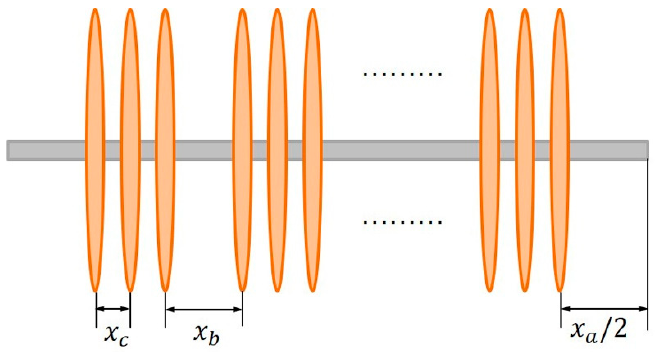
Figure 5. Schematic diagram of fracture distribution of staged fractured horizontal well.